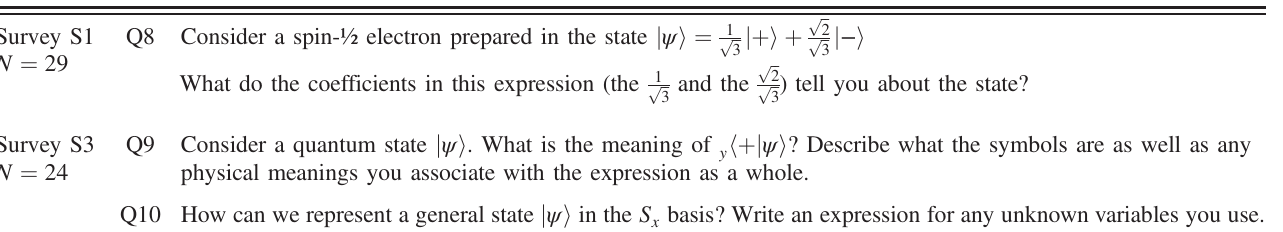
TABLE III. Survey questions targeting RQ3 regarding students ’ interpretations of coefficients in a basis expansion. Survey S1 also included questions presented in Table I. Like surveys S1 and S2, survey S3 was administered at one institution in the quantum mechanics